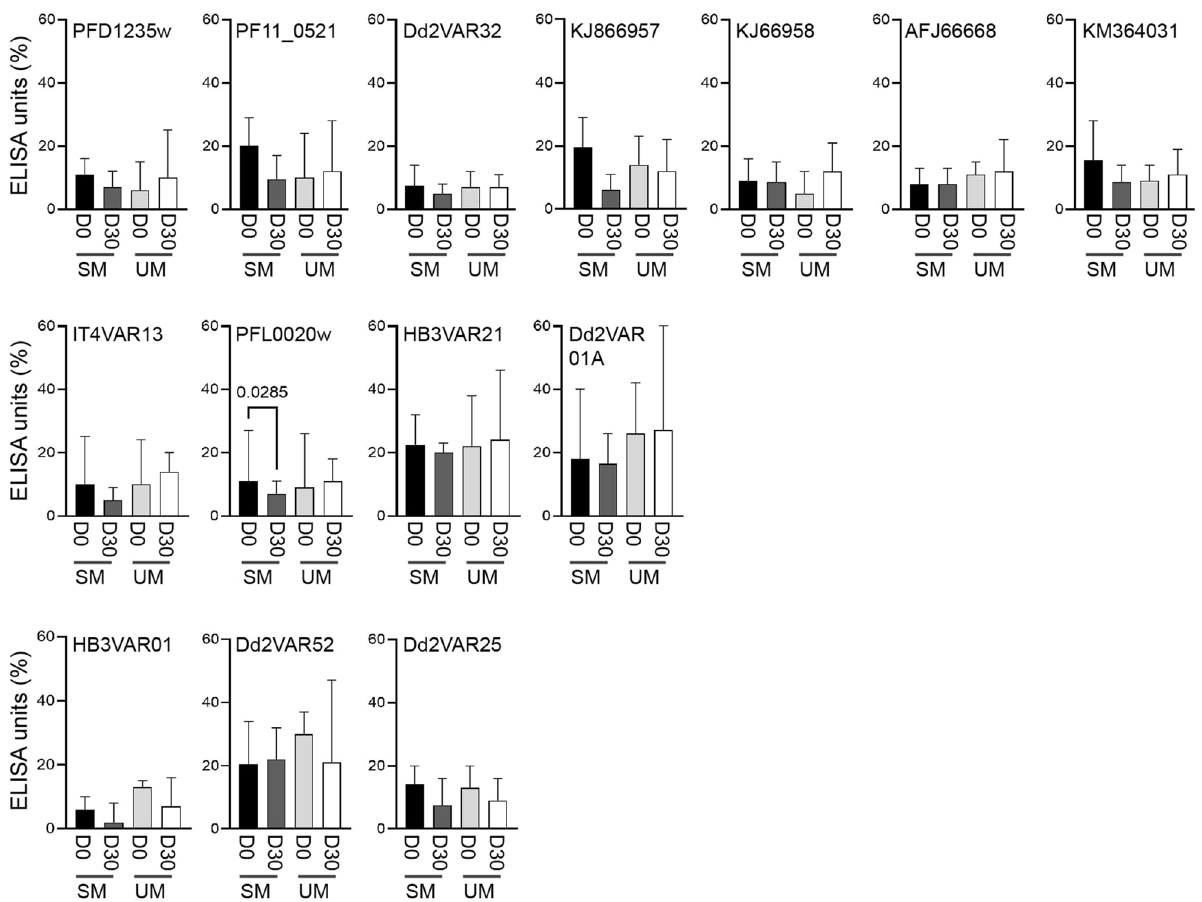
Figure 2. Plasma IgG levels against DBLβ in children in matched children´s samples and clinical categories. The anti-DBLβ antibody reactivity (ELISA units; EU) of the individual children shown in Fig. 1 were grouped according to clinical disease category, i.e., severe malaria (SM including CM and nCSM; n = 28), and uncomplicated malaria (UM, n = 27) at the day 0 (hospitalization) and day 30 (convalescent) samples. The reactivity was measured against the same DBLβ domains as in Fig. 1. Statistical significance comparing the different groups was determined using Wilcoxon matched pairs signed rank test, no significant differences